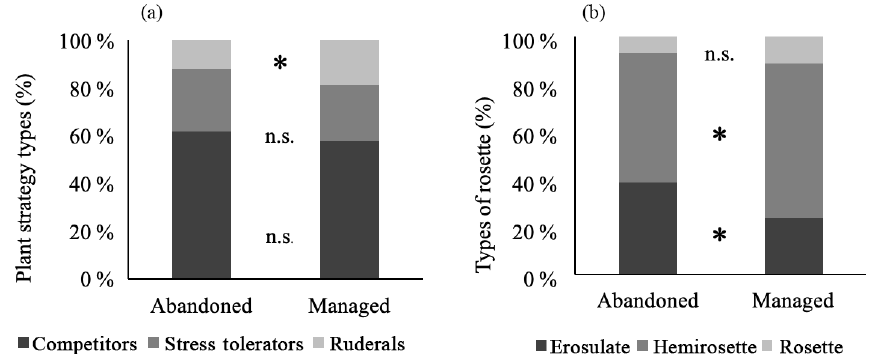
Figure 4. Proportion of plant strategy types (a) and proportion of types of rosettes (b) in abandoned and managed meadows. ∗ denotes significant difference between management types ( p < 0 . 05), n.s. no significant difference. Values are means.